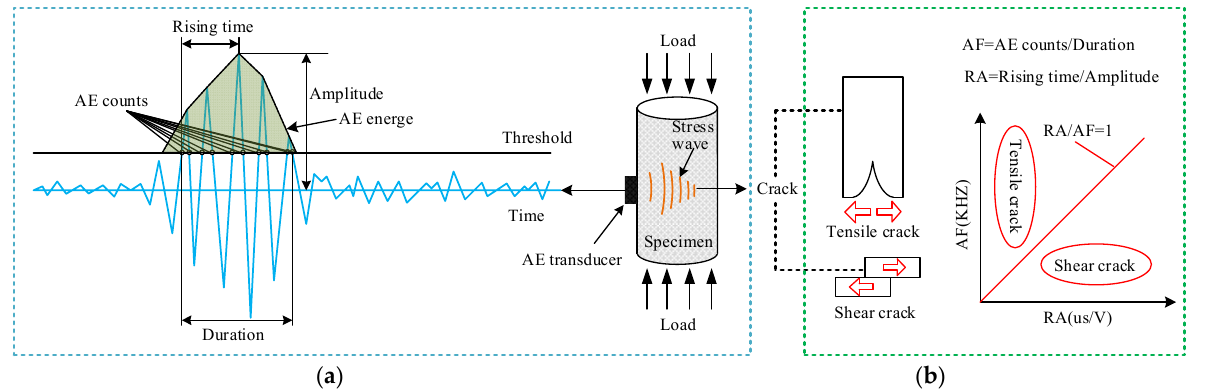
Figure 5. Schematic diagram of AE characteristic parameters and crack mode: ( a ) AE parameters; ( b ) characterization method of crack mode.